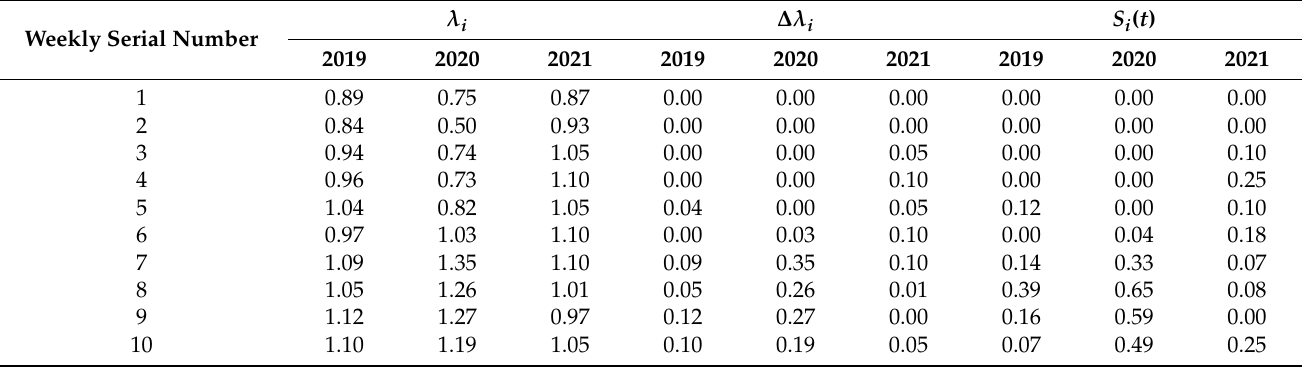
Table 10. Calculation results of the patency degree, patency degree deviation, and system entropy in each week of the NPTHN from 2019 to